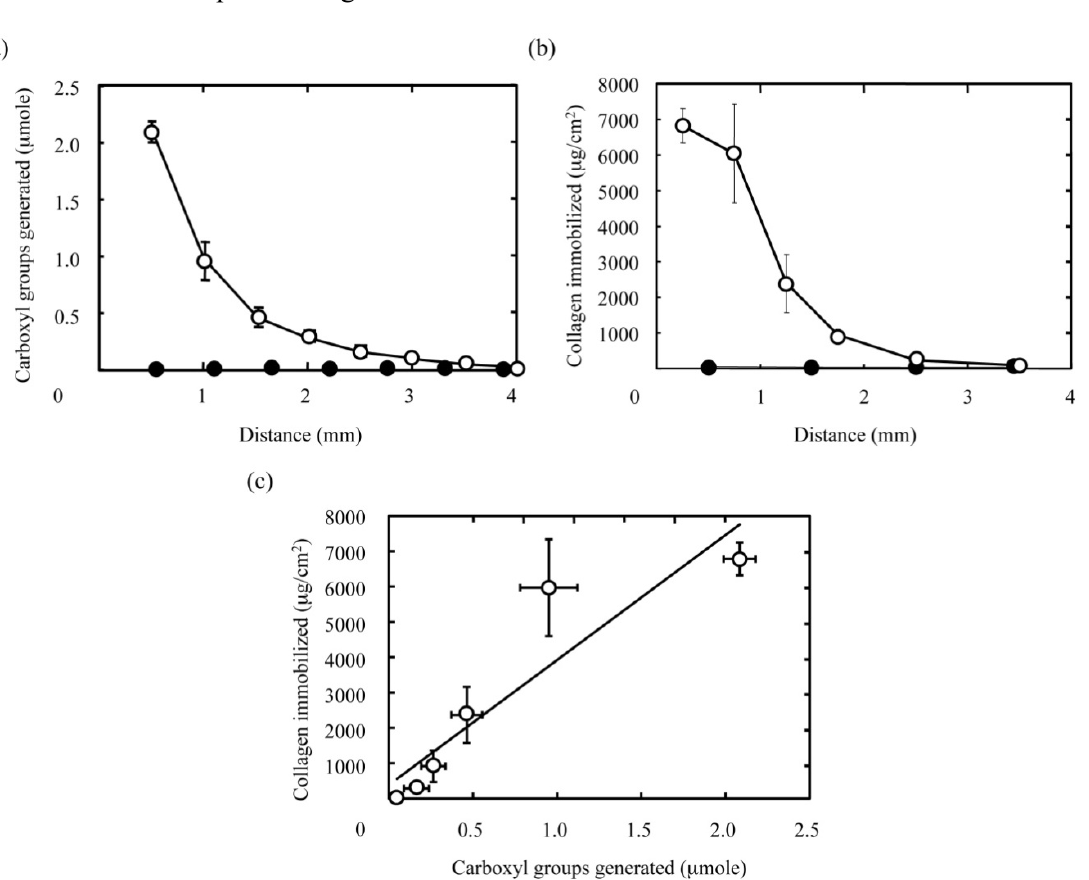
Figure 4. The immobilization pattern of type I collagen in PAAm hydrogels with a concentration gradient of carboxyl groups. (a) The concentration gradient of carboxyl groups in PAAm hydrogels generated by the hydrolysis for 30 min with 1 M NaOH ( ) and NaOH-free solutions ( ). The X-axis indicates the distance from the surface of hydrogel facing the NaOH solution. (b) The amount of collagen immobilized in the corresponding hydrogels to (a). (c) The relationship between the amounts of carboxyl groups generated and collagen immobilized in PAAm hydrogels. The coefficient of determination, R 2 value for the least mean square fitting is